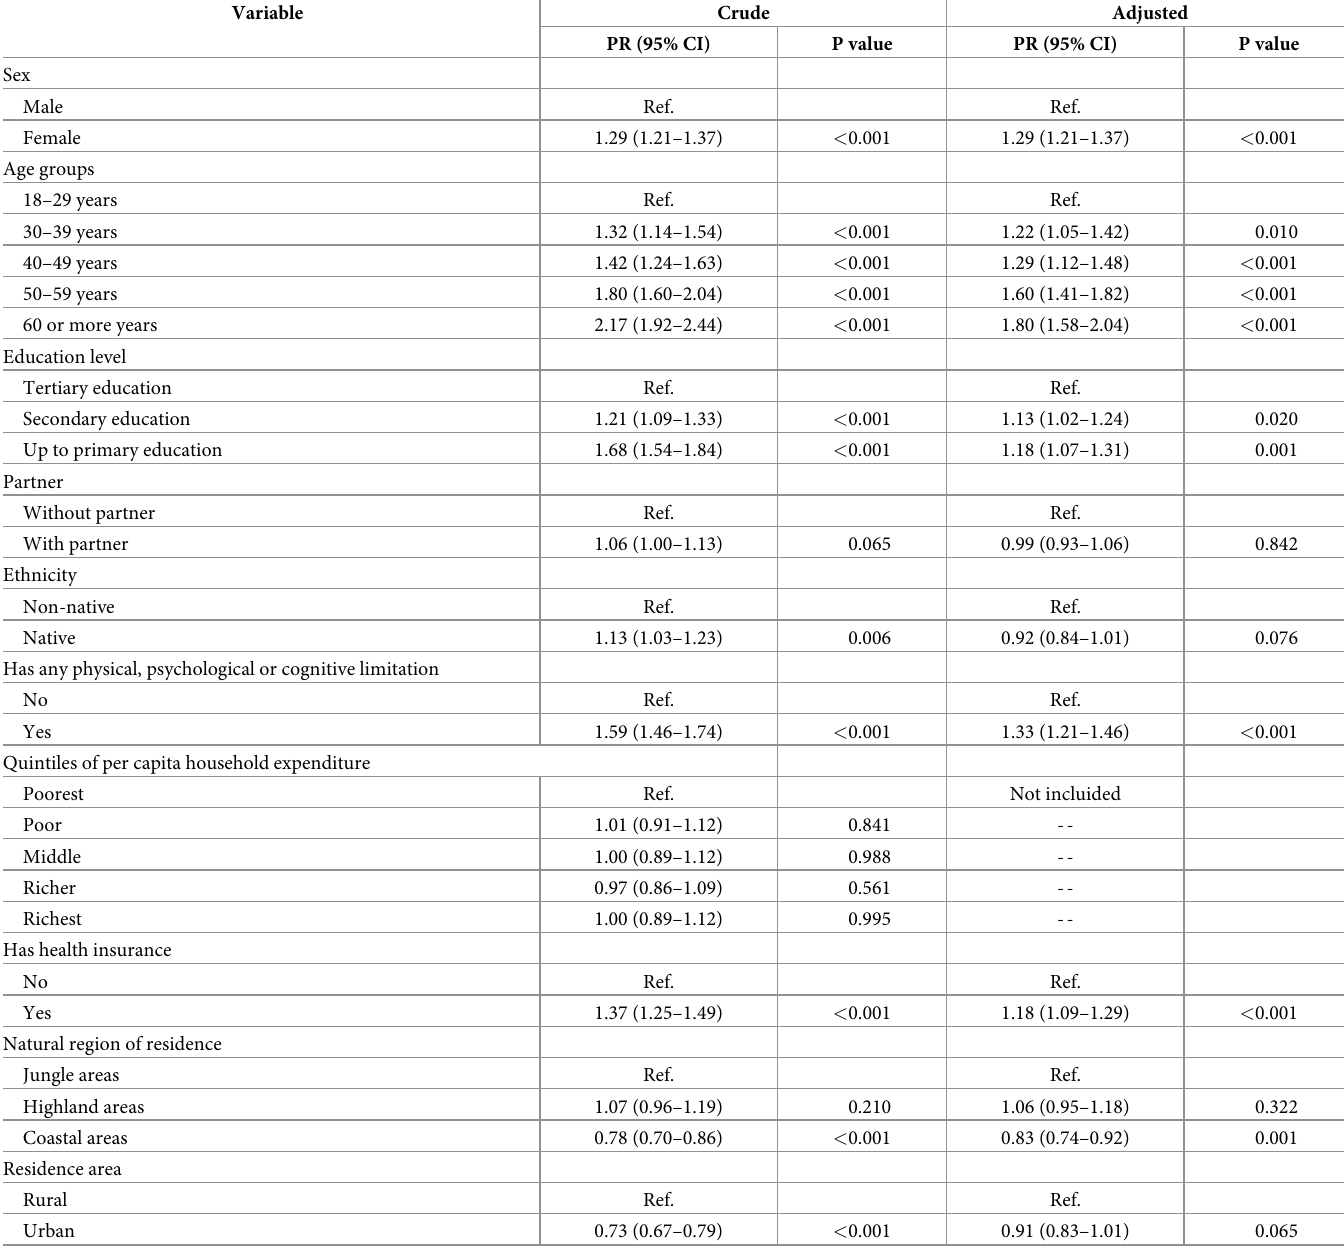
Table 2. Crude and adjusted prevalence ratios of chronic disease